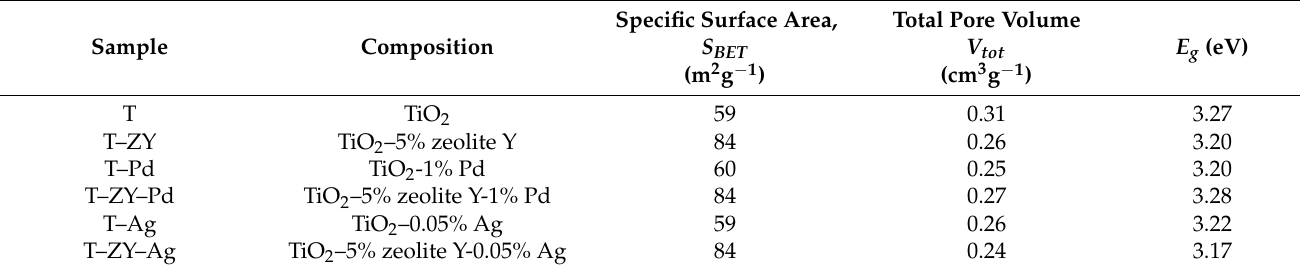
Table 1. Specific surface area ( S BET ), pore volume ( V tot ) (determined by nitrogen adsorption) and experimental band gap energy ( E g ) values obtained from the analysis of Tauc plot [25]. Specific Surface Sample Composition